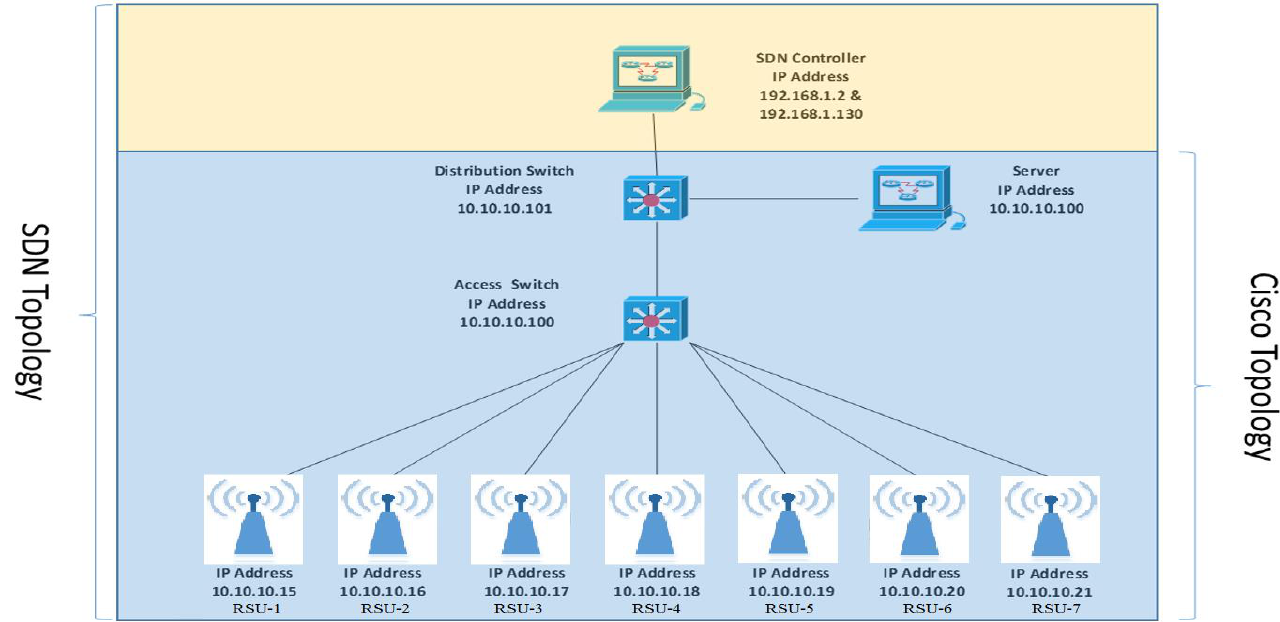
Figure 3. Network Diagram for Throughput Test Table 3. List of equipment used for setup [30,